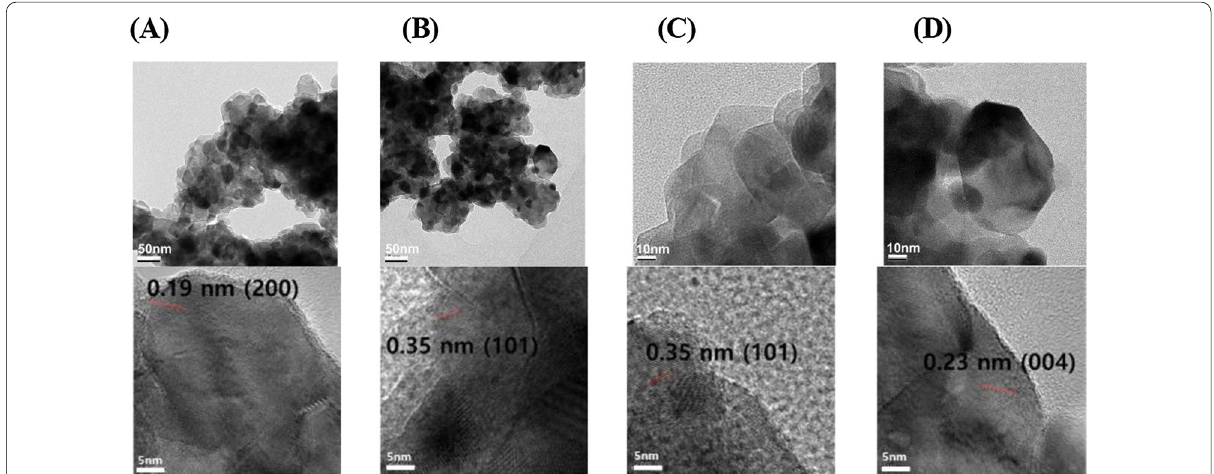
Fig. 3 FE‑TEM images of EtOAc‑TiO 2 NPs. Each enlarged picture clearly shows the distance between neighboring lattice fringes and their corresponding plane. a A distance of 0.19 nm with the (200) plane, b a distance of 0.35 nm with the (101) plane, c a distance of 0.35 nm with the (101) plane, and d a distance of 0.23 nm with the (004)